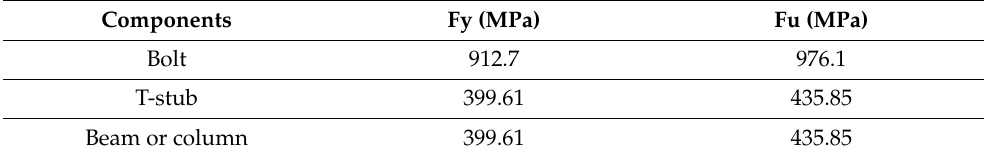
Table 1. Value of F y and F u